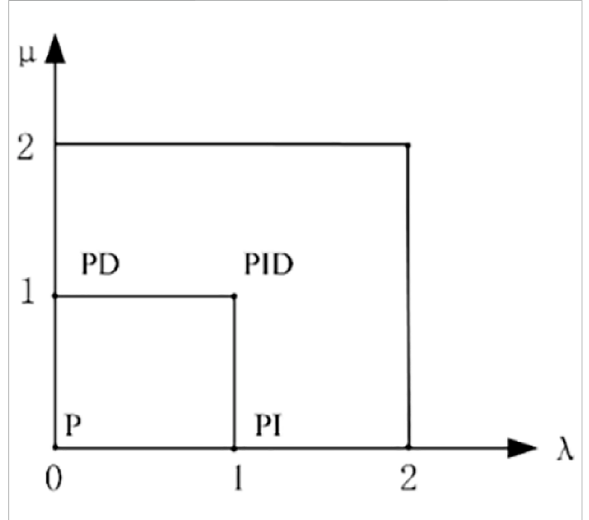
FIGURE 10 Order valuerange oftheFOPID controller.The mathematical expression of FOPID is given.